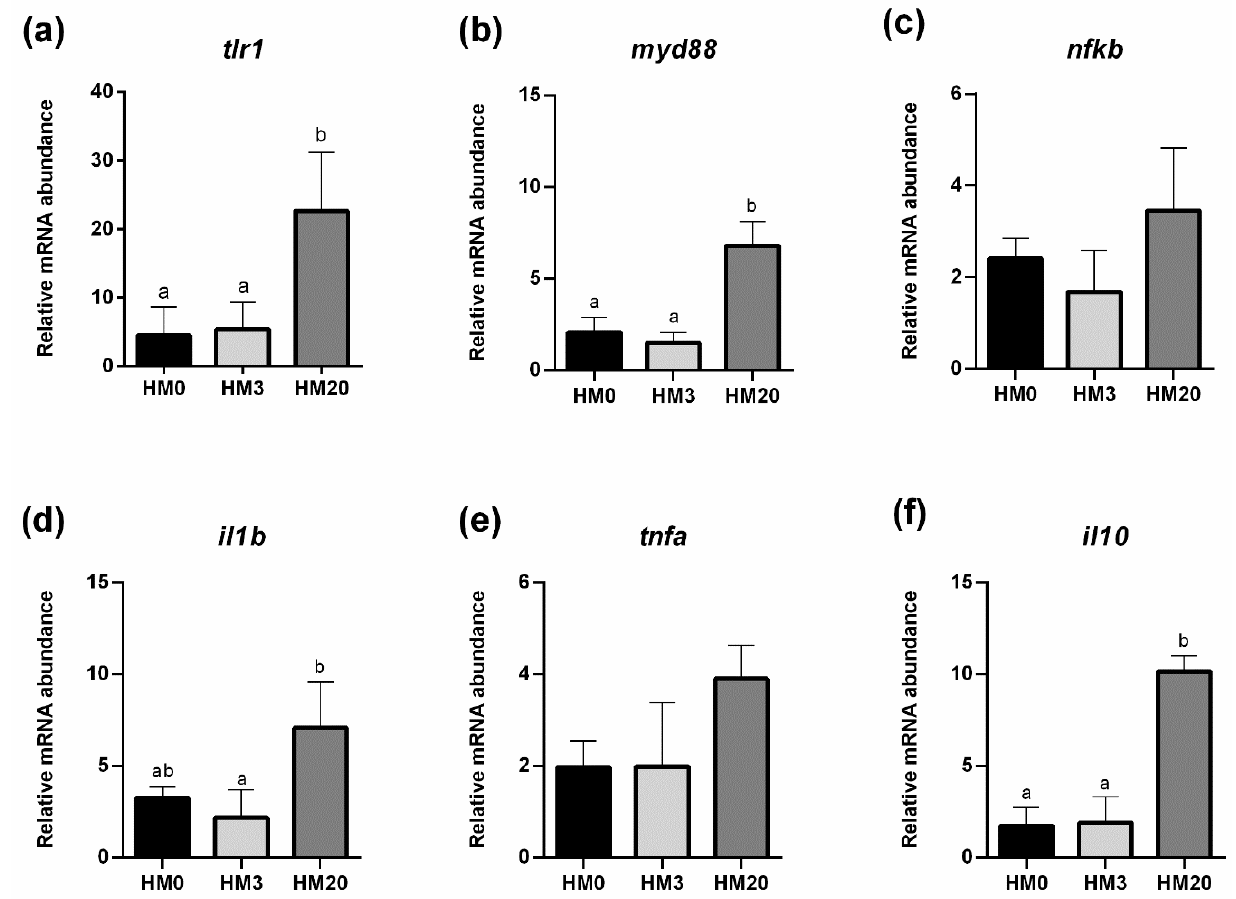
Figure 7. Relative mRNA abundance of genes involved in immune response, analyzed in distal intestine samples of rainbow trout fed the experimental diets. ( a ) tlr1 , ( b ) myd88 , ( c ) nfkb , ( d ) il1b , ( e ) tnfa , ( f ) il10 . Values are shown as mean ± SD ( n = 9). Different letters indicate significant differences among experimental groups ( p < 0.05).